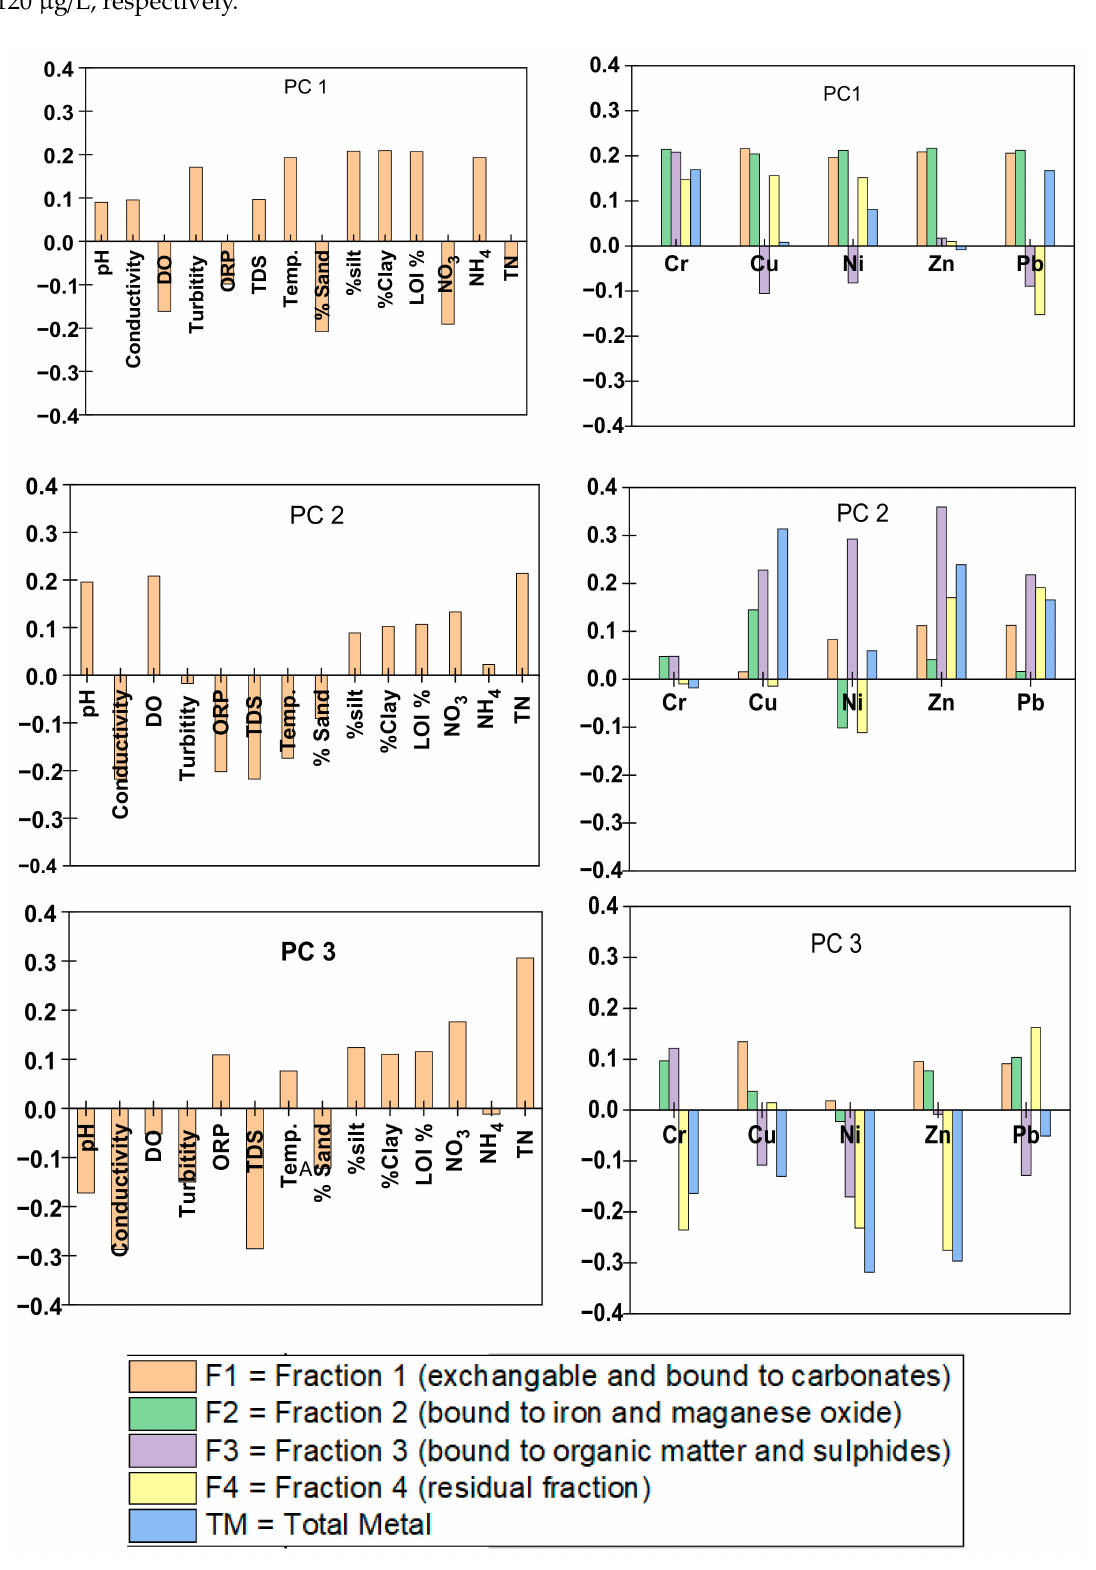
Figure 3. Sub-plots of variable loadings on principal component 1 (PC 1), principal component 2 (PC 2), principal component 3 (PC